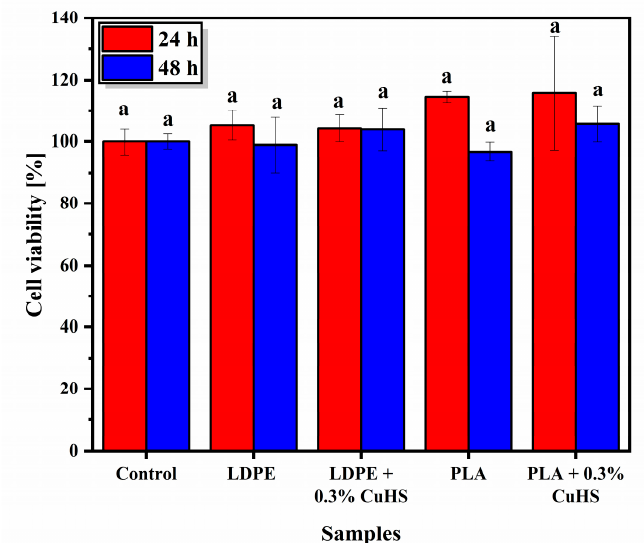
Figure 6. Effect of neat LDPE and PLA films and their corresponding composite film with 0.3% CuHS on HeLa-type cell viability. The error bars show the standard deviation of the four replicates performed. Similar letters/symbols mean no statistical significance, while different letters/symbols mean statistical significance.